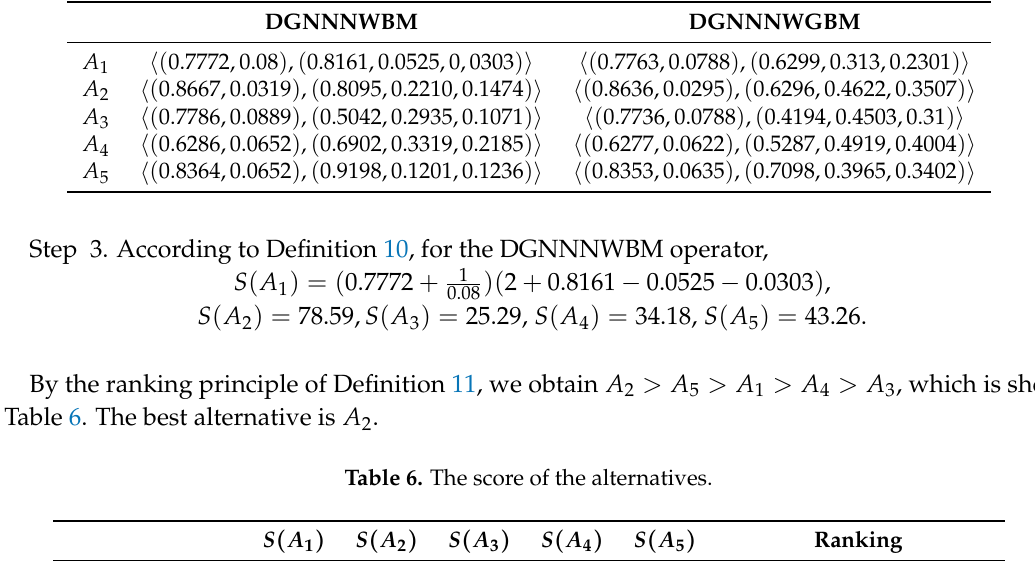
Table 5. Utilization of the dual generalized nonnegative normal neutrosophic weighted Bonferroni